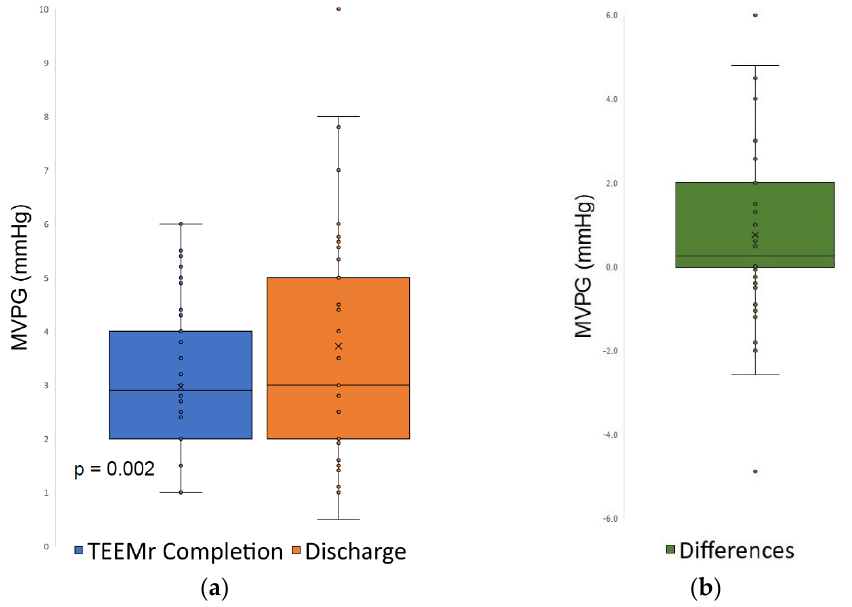
Figure 3. Mitral valve pressure gradient at completion of TEEMr and at discharge. ( a ) Changes in MVPG at TEEMr completion and at discharge. The cross-line marks the median of the measurements (50% quartile). The boxes represent the 25% to 75% interquartile values. The whiskers mark the smallest and largest measurements. The circles represent outliers. MVPG increased significantly (from 3 ± 1.4 mmHg at the completion of TEEMr to 3.7 ± 1.9 at discharge; p = 0.002); ( b ) Box plot of differences; MVPG, Mitral valve pressure gradient; TEEMr, Transcatheter edge-to-edge Mitral valve repair.